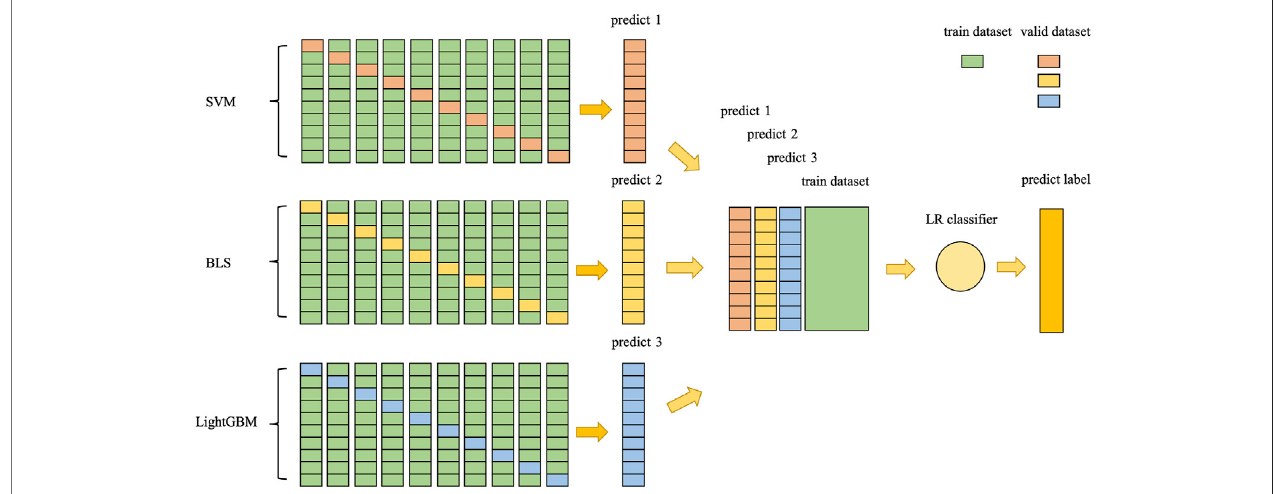
FIGURE 5 | The framework of stacking ensemble classi fi